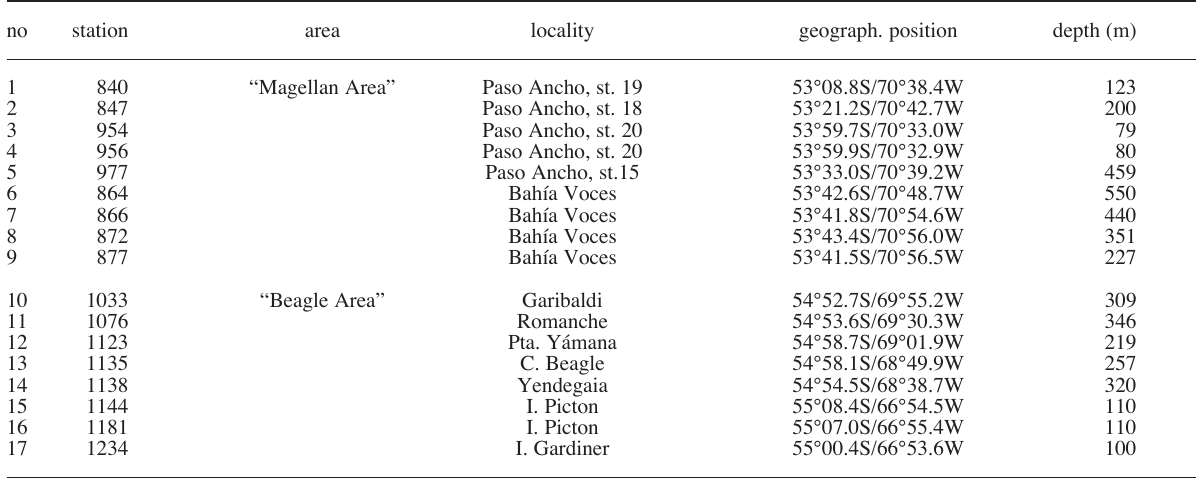
T ABLE 1. – List of the sampling stations studied from the Magellan Straits and the Beagle Channel. The list presents the station number, its locality, geographical position and depth.